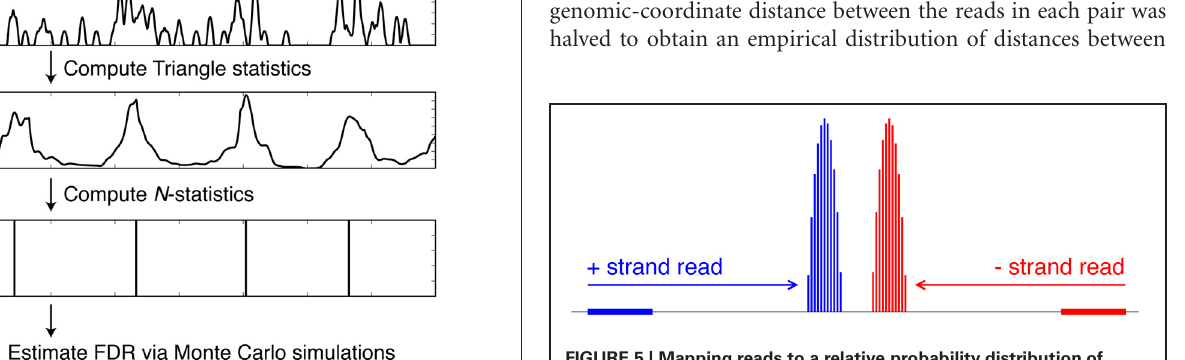
FIGURE 5 | Mapping reads to a relative probability distribution of nucleosome centers. A positive-strand alignment is mapped to a discretized beta distribution whose leftmost bin is 68 bins to the right of the read’s start position (blue). A negative-strand alignment is mapped to a discretized beta distribution whose rightmost bin is 68 bins to the left of the read’s start position